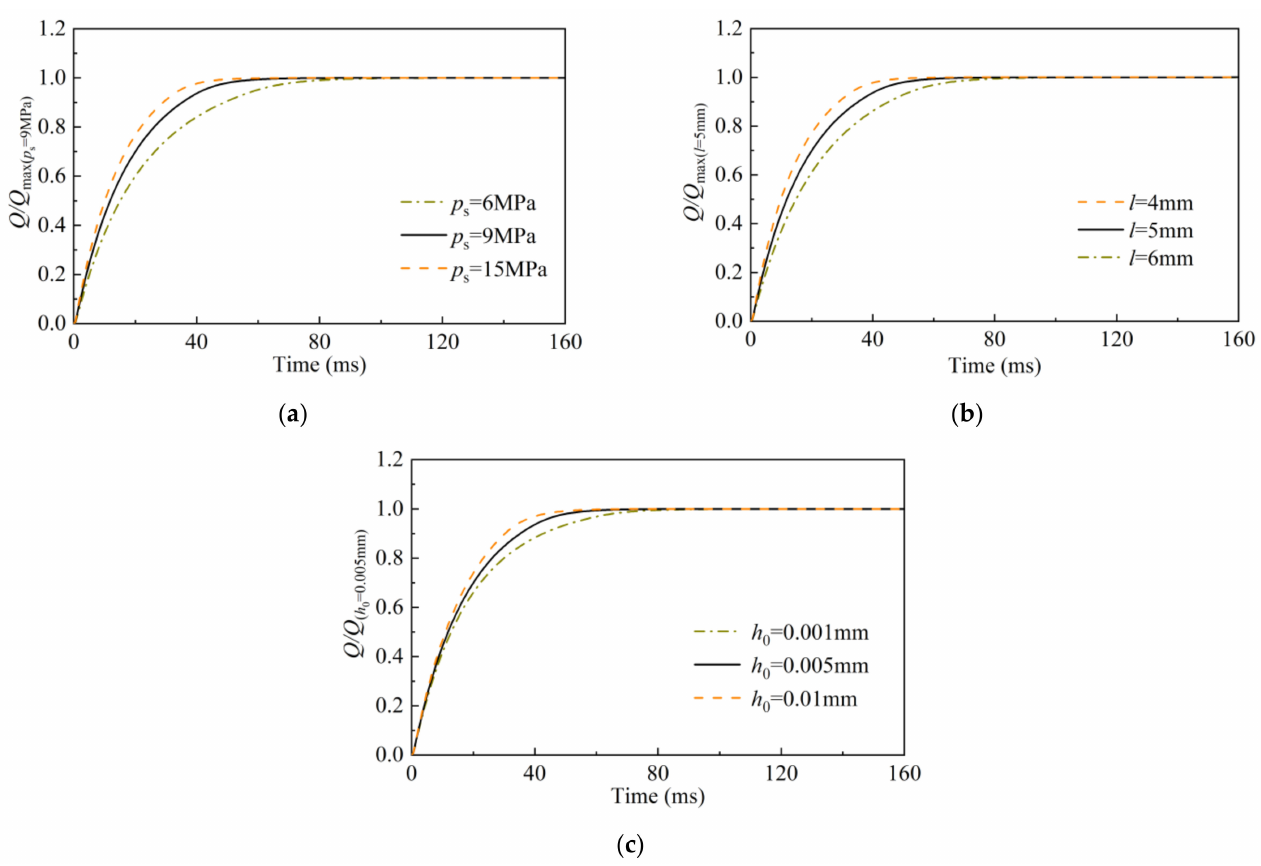
Figure 11. The effect of key parameters on the step response. ( a ) Effect of system pressure on the step; ( b ) effect of damping piston length on the step; ( c ) effect of initial overlap height on the